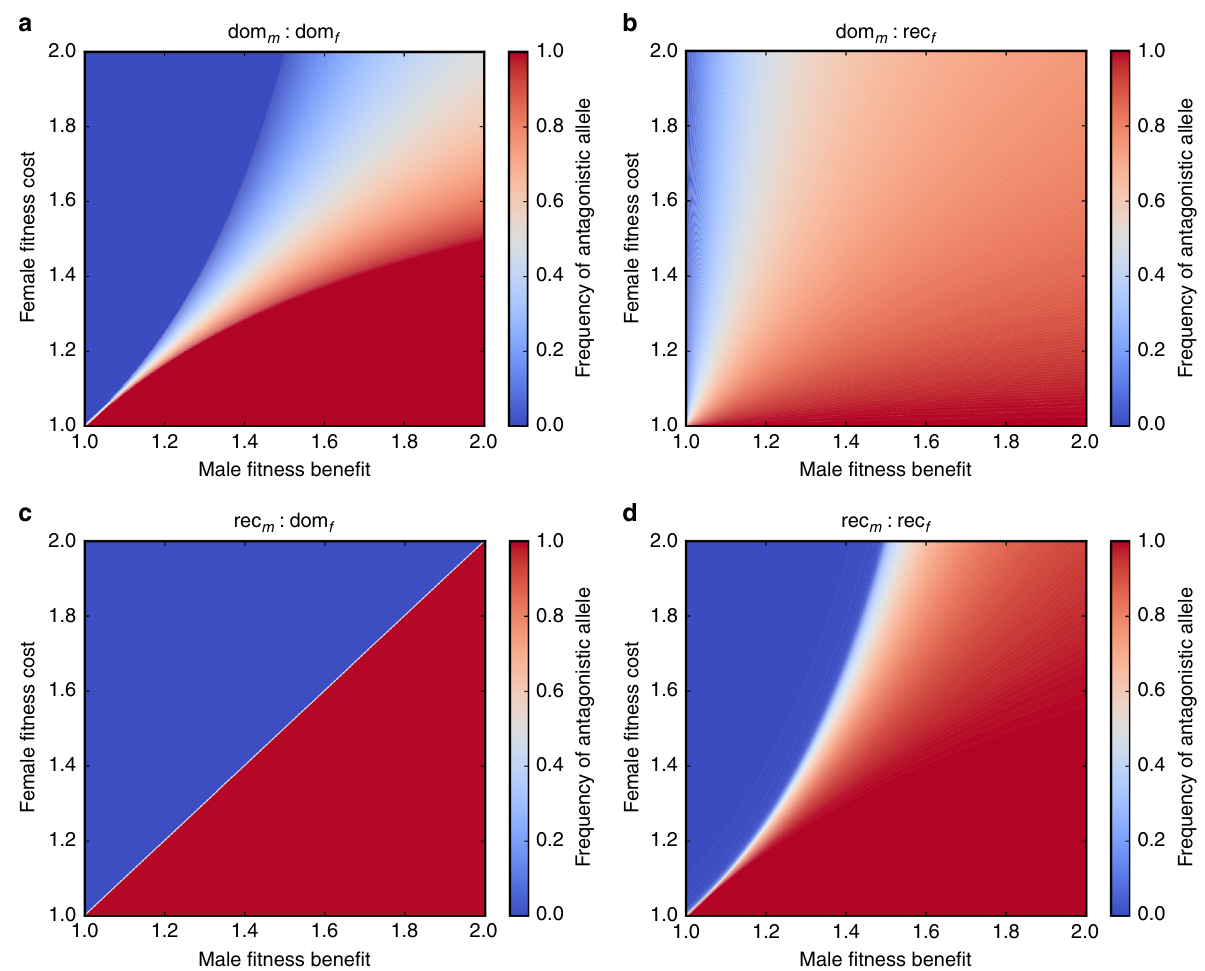
Fig. 1 Population-level allele frequencies are determined by sex-speci fi c fi tness costs and bene fi ts. The graphs show equilibrium allele frequency from simulating our two-sex models over a wide range of male- fi tness bene fi ts (relative reproductive success of males with the allele compared to males lacking the allele) and female- fi tness costs (relative reproductive success in females with the allele compared to females lacking the allele). The red regions show the conditions where the sexually antagonistic allele goes to fi xation, the blue regions indicate where the allele will be lost and the white/colour mixed regions show where both allelic variants coexist. Each panel assumes a different mode of inheritance: the allele is dominant in both sexes ( a ), dominant in males but recessive in females ( b ), recessive in males but dominant in females ( c ) or recessive in both sexes ( d